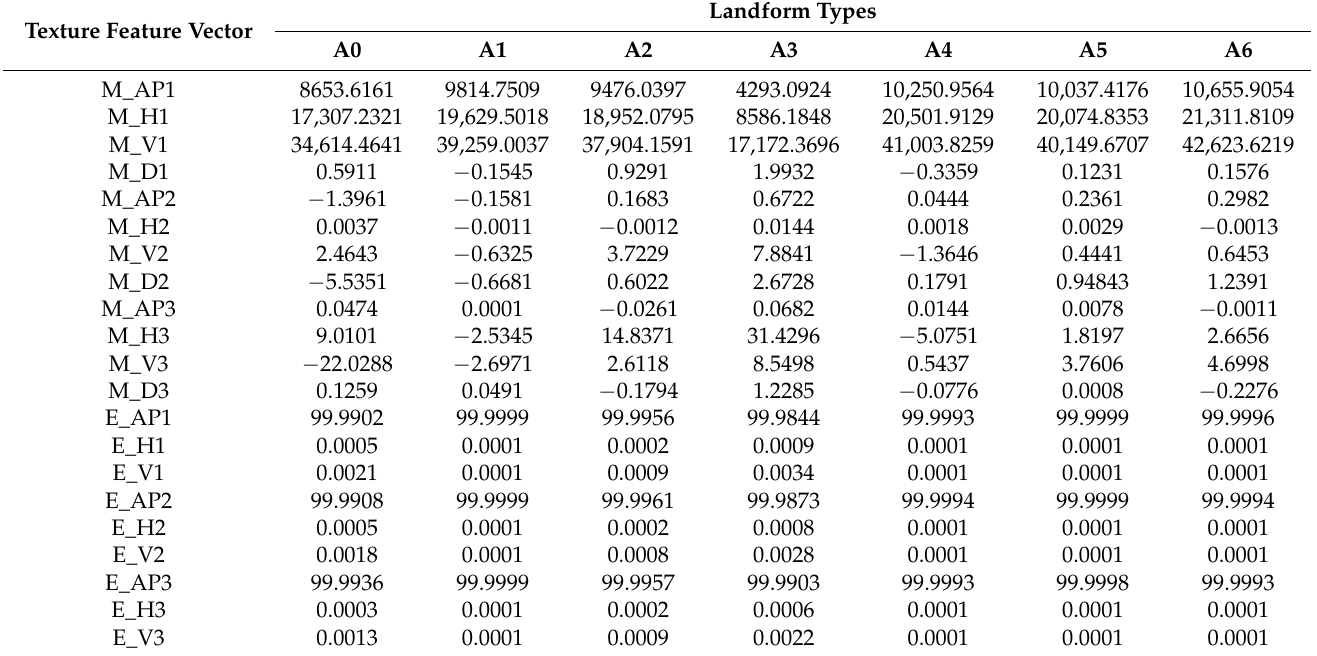
Table 1. Wavelet eigenvalues of different landform